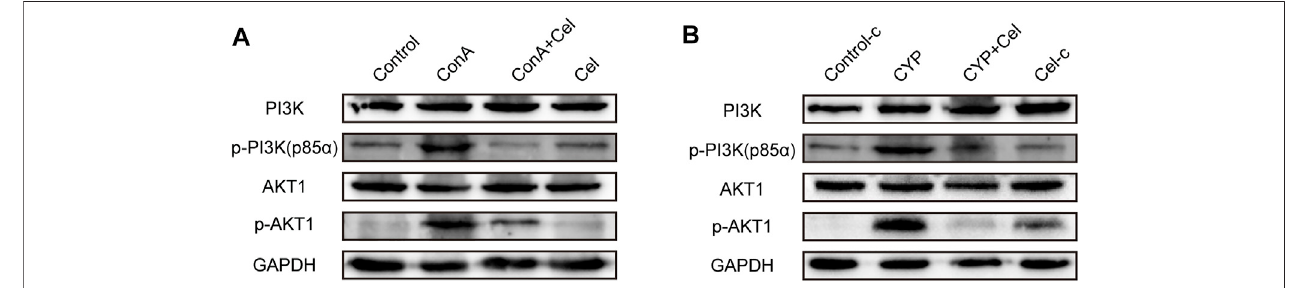
FIGURE 9 | Effect of celastrol on phosphorylation of PI3K/AKT pathway proteins. (A) and (B) represent the inhibition effect of celastrol in ConA-induced liver injury and experimental AIH models, respectively. Supplementary Figure S1 . Pre-experiment of therapeutic effect of different drug concentration. (A) Gross appearance of livers. (B) Body weight